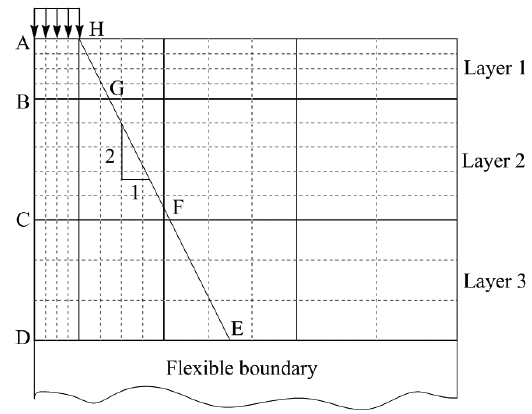
Figure 6. The element regions used to calculate the equivalent resilient modulus (Harichandran, Yeh, & Baladi, 1990)